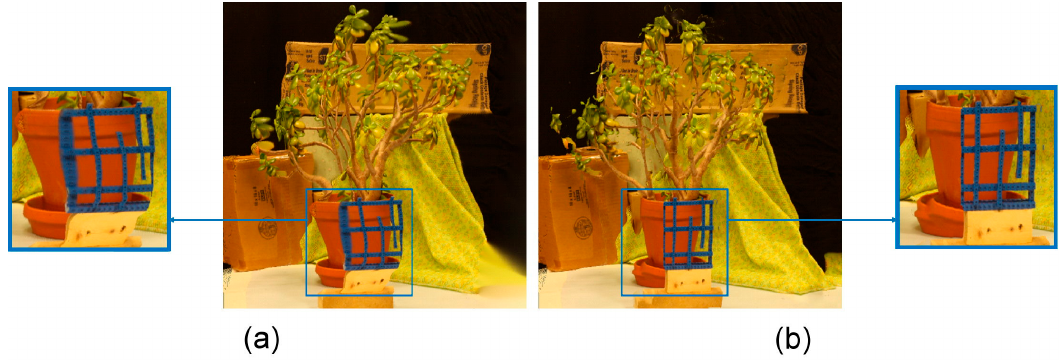
Figure 10. Comparison of the results obtained using ( a ) warping and ( b ) our model.